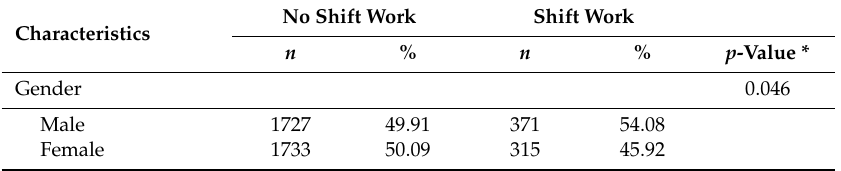
Table 1. The general and occupational characteristics of study population by shift